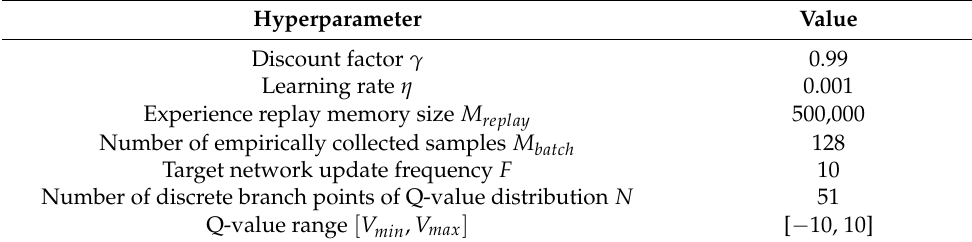
Table 2. Network training